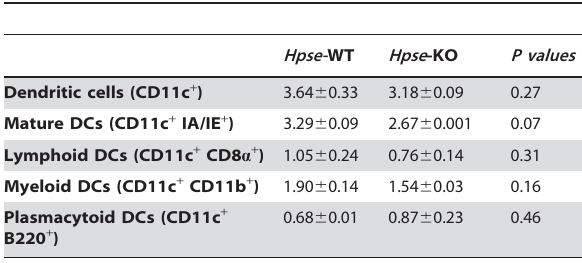
Table 1. DC subpopulations in the spleen of wild type ( Hpse- WT) and heparanase-deficient mice ( Hpse